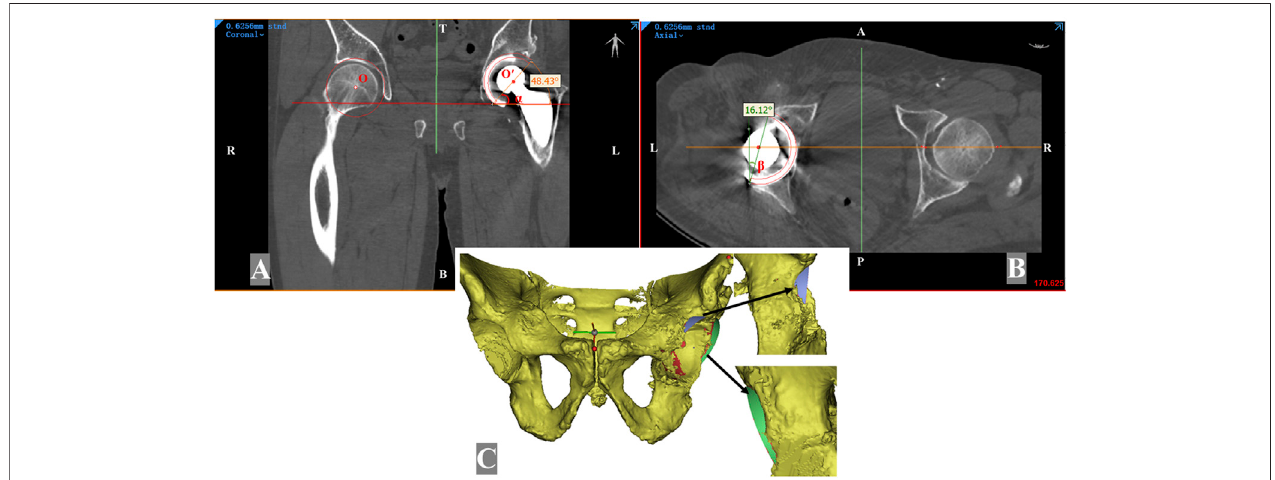
FIGURE 2 | Measurement of the simulated implanted acetabular cup on the Mimics software. The reoriented planes (A, B) are resliced from the anterior pelvic plane. The hip center of rotation on the implanted acetabular cup side is marked as point O; the contralateral normal center of rotation is determined by Mose technique andmarkedaspointO ′ .TheverticaldistancebetweenpointOandpointO ′ isthehiprotationcenterelevation.Theinclinationangle( α )wasmeasuredinthecoronalplane (A) , and the anteversion angle ( β ) was measured in the axial plane (B) . (C) Segmentation was performed according to the border between the covered part (red region) and the uncovered part (blue region and green region) of the acetabular